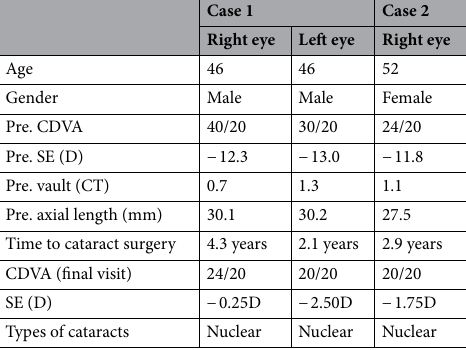
Table 3. The cases of ICL extraction and cataract surgery after Hole implantable collamer lens (ICL) implantation. CDVA corrected distance visual acuity, SE spherical equivalent, CT corneal